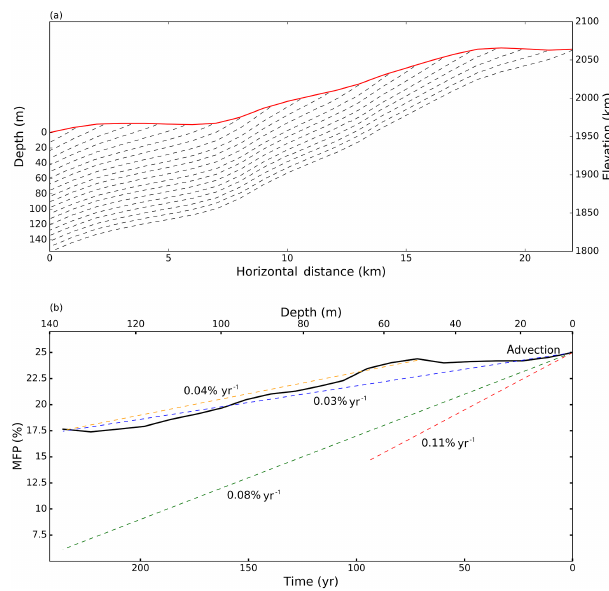
Figure 5. (a) Surface topography and modeled flow lines extending inland from Crawford Point. The horizontal distance scale is kilo- meters from Crawford Point. The bottom panel (b) shows the mod- eled change in MFP over time (bottom axis) and with depth (top axis) resulting from ice flow alone. Depth scale in (b) corresponds to firn depth in (a) . Time trends in MFP at Crawford Point arising from simulated ice flow are shown for the full time (or depth) period (blue) and for the firn profile below 50m (orange). Time trends in MFP measured in a Crawford Point ice core and reported by Hig- gins (2012) for the entire period (green) and the 1900–2007 period (red) are shown for